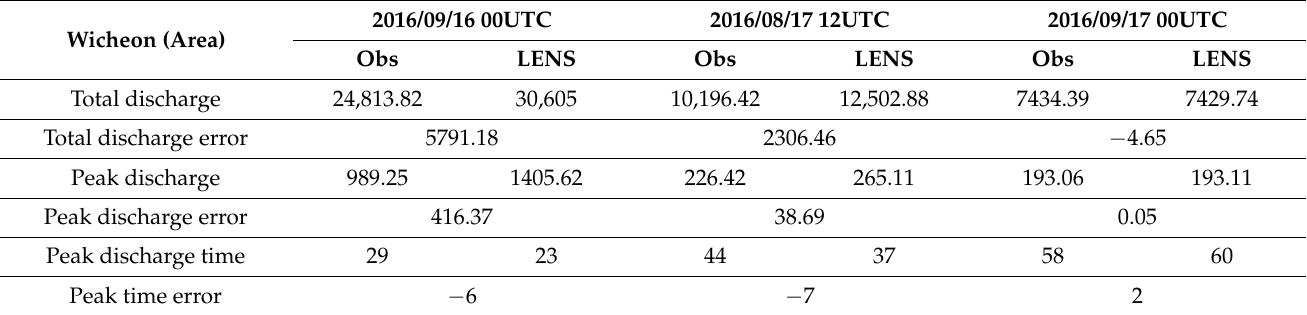
Table 15. LENS area discharge data results from 2016/09/16 00UTC to 2016/09/17